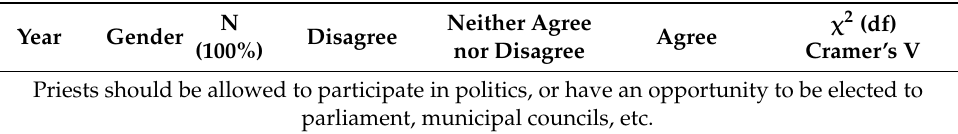
Table 3. Anti-clergy sentiments among Roman Catholic men and women in